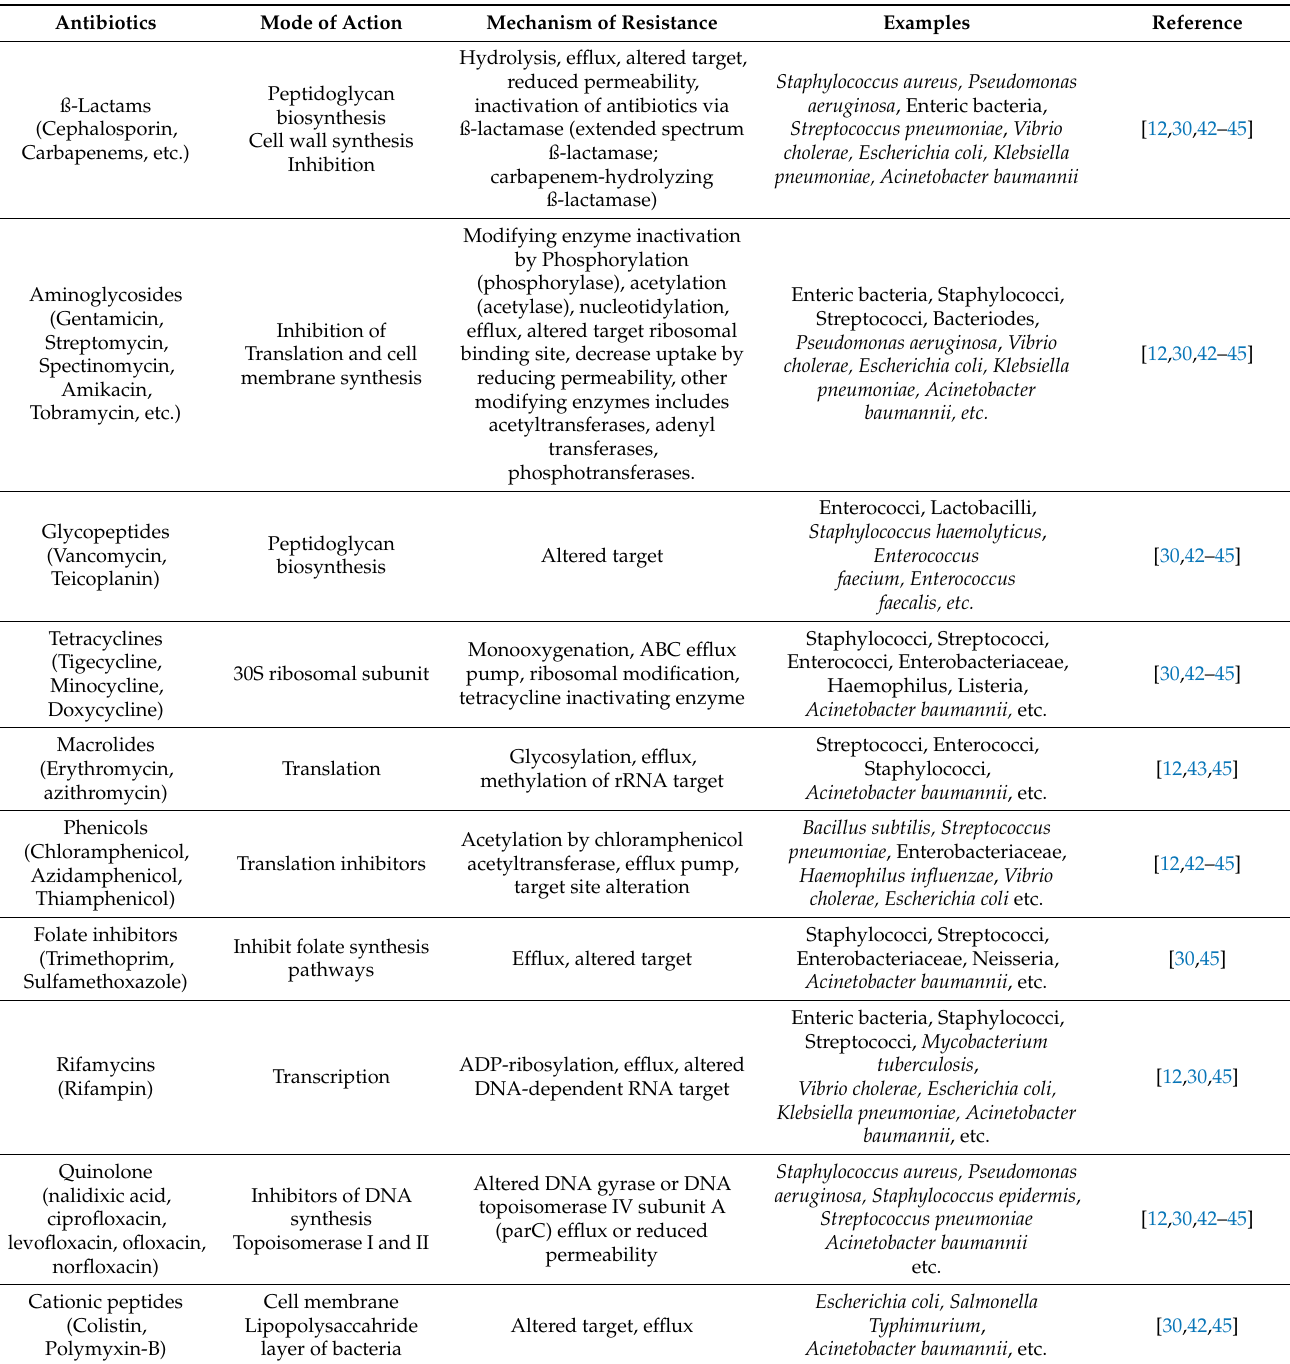
Table 1. Different mode of action of antibiotics and its resistance mechanisms along-with few bacterial